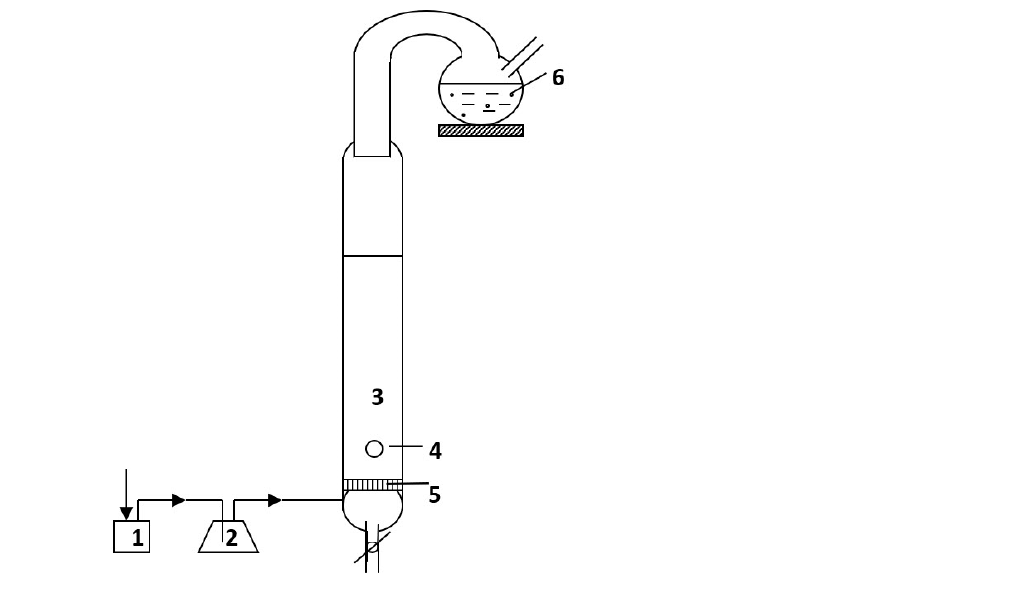
Table 4. Results of Zn(II) and Mn(II) flotation using collector 32 in a 10 min process with and with- out foaming agent 29 at a pH from 2.0 to 11.0; (Zn) = 0.00168 M, (Mn) 0.00091 M, (32) = 5.0 × 10 − 3 M, (29) = 2.0 × 10 − 4 M.